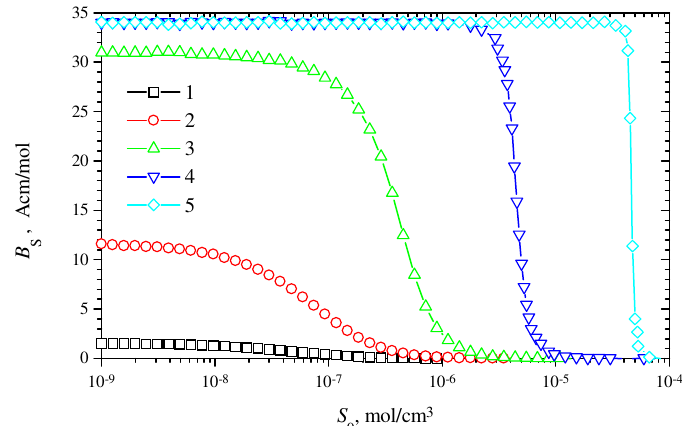
Figure 8 . The dependence of the biosensor sensitivity B S (formula 20) on the substrate concentration S at five maximal enzymatic rates V : 10 -10 (1), 10 -9 (2), 10 -8 (3), 10 -7 (4) and 10 - 0 max 6 (5) mol/cm 3 s. Other parameters are the same as in Fig. 7.